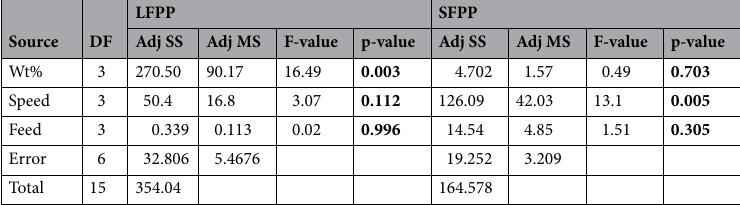
Table 10. ANOVA general linear model for drilled PP and GFR/PP under different drilling conditions. Significant values are in bold.